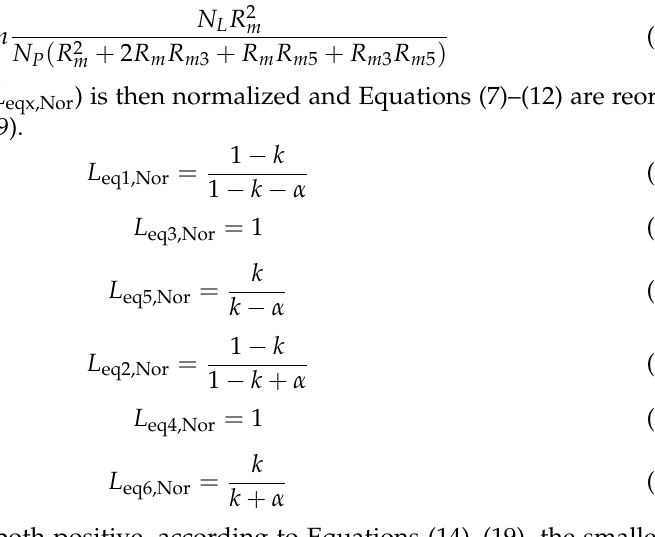
The common term in Equations (7)–(12) is substituted with a single variable to obtain Equation (13).